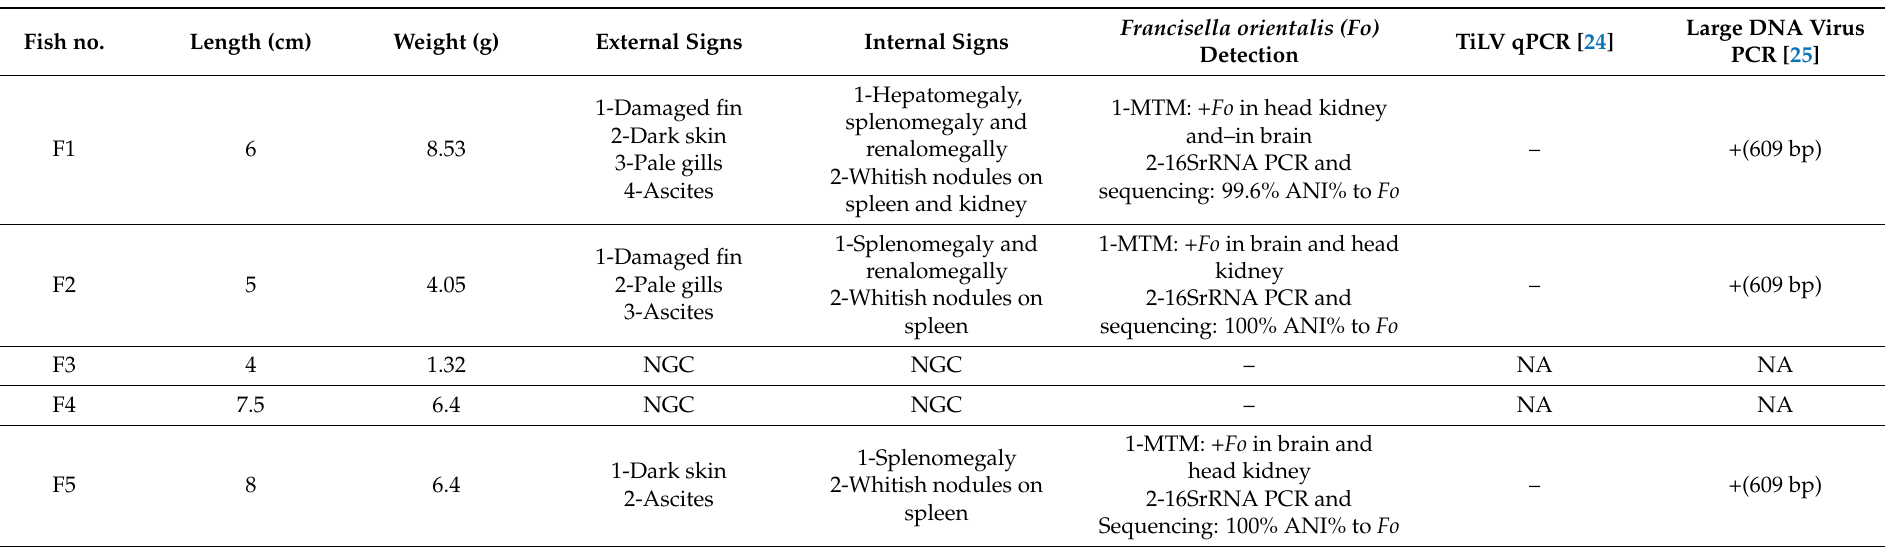
Table 2. Metadata from diagnostic screening of tilapia from Southern CA, USA naturally infected with novel megalocytivirus. Fish